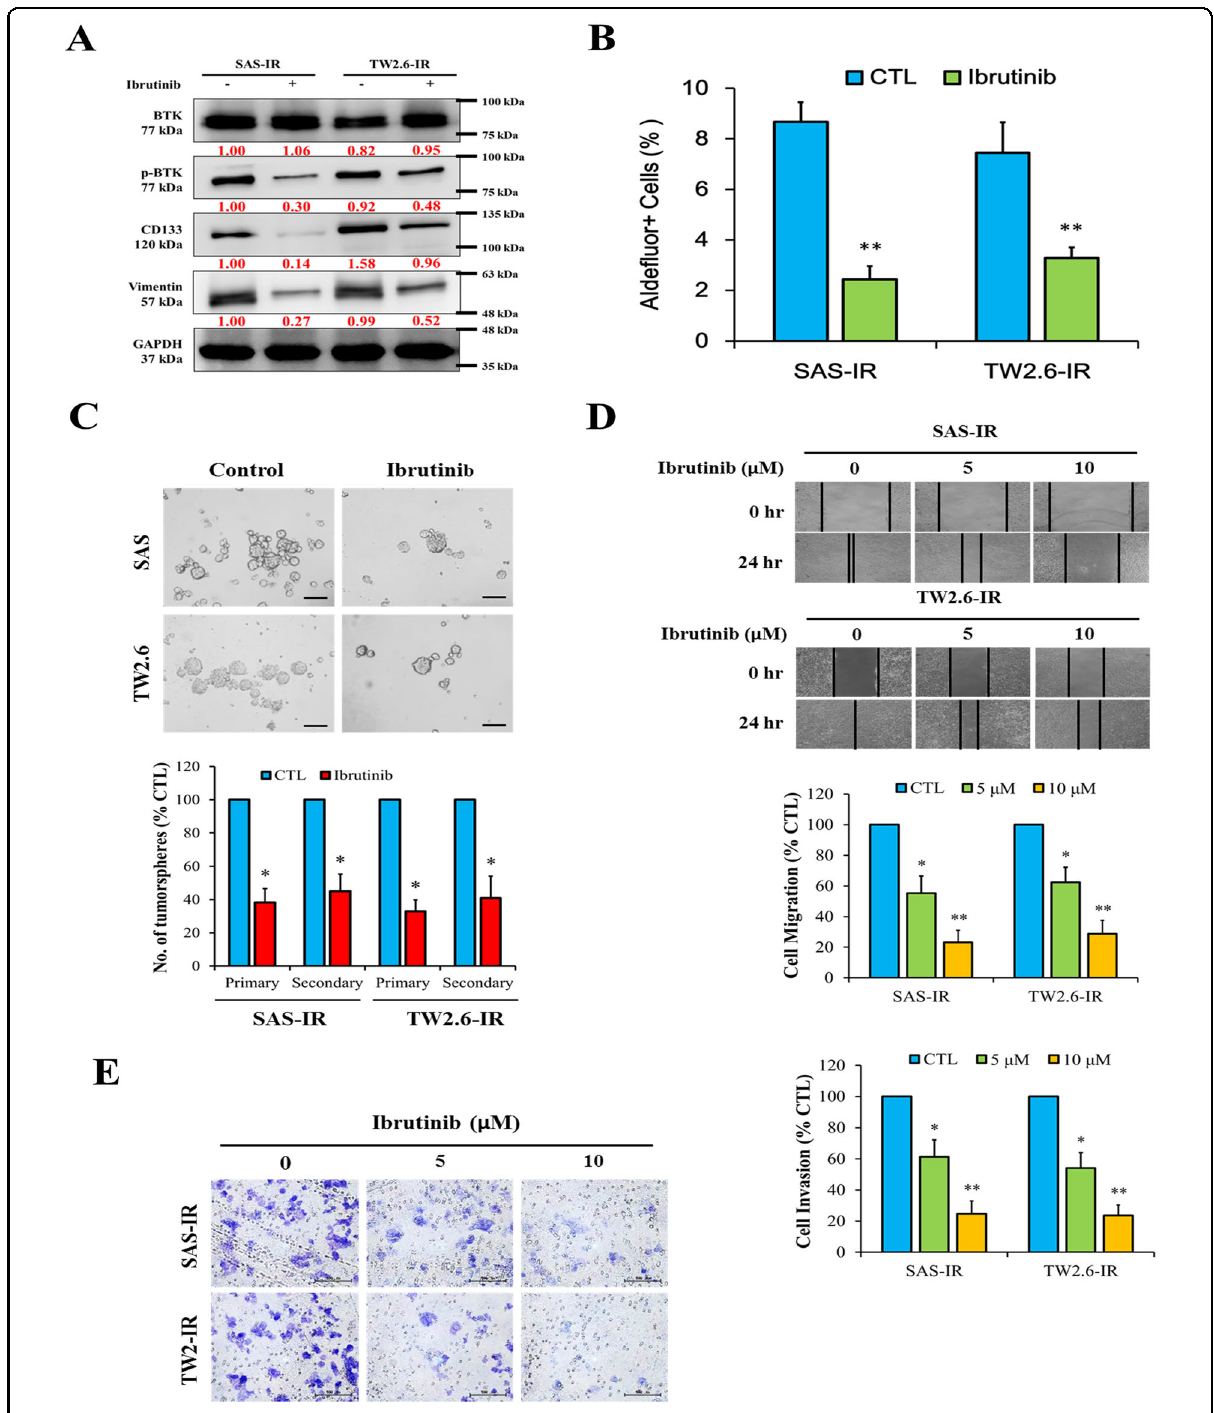
Fig. 4 The CSCs-like trait of ALDH-rich oral cancer cell lines is signi fi cantly suppressed by ibrutinib. A Western blot indicated the expression levels of BTK, pBTK, stemness marker CD133, and EMT marker vimentin in SAS-IR and TW2.6-IR cell lines. GAPDH was used as a loading control. B Representative data showing the effect of pre-exposing SAS-IR and TW2.6-IR cells to 0 μ M (control) or 10 μ M (treated) ibrutinib for 48 h, on their ALDH activity as detected by fl ow cytometry-based ALDEFLUOR assay and the graphical quantitative analysis of treated ALDH + compared with control cells. C The reducing effect of ibrutinib pretreatment on OSCC tumorsphere formation from SAS and TW2.6 ( left ), and quantitative representation of the effect of ibrutinib treatment on primary and secondary tumorsphere formation from SAS and TW2.6 cells ( right ). D , E Representative images illustrating that treatment with ibrutinib signi fi cantly reduced the migration and invasion ability of SAS-IR and TW2.6-IR OSCC cells in a dose- dependent manner. Graphical quantitative data showing the relative number of cells in ibrutinib-treated cells compared with control cells. All experiments performed in triplicates and expressed as mean ± SD. * p < 0.05, ** p < 0.01.